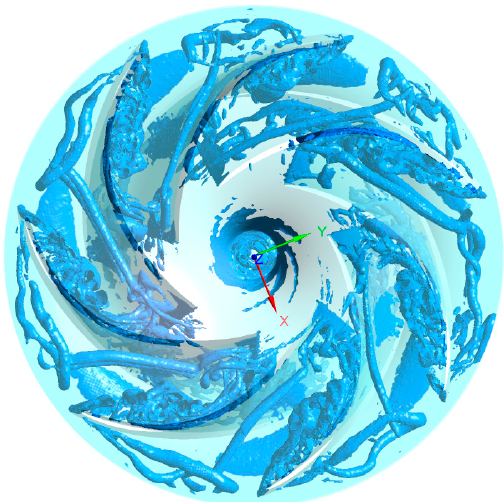
Figure 5. Vortex structures at 75%Pn (10% characteristic scale).